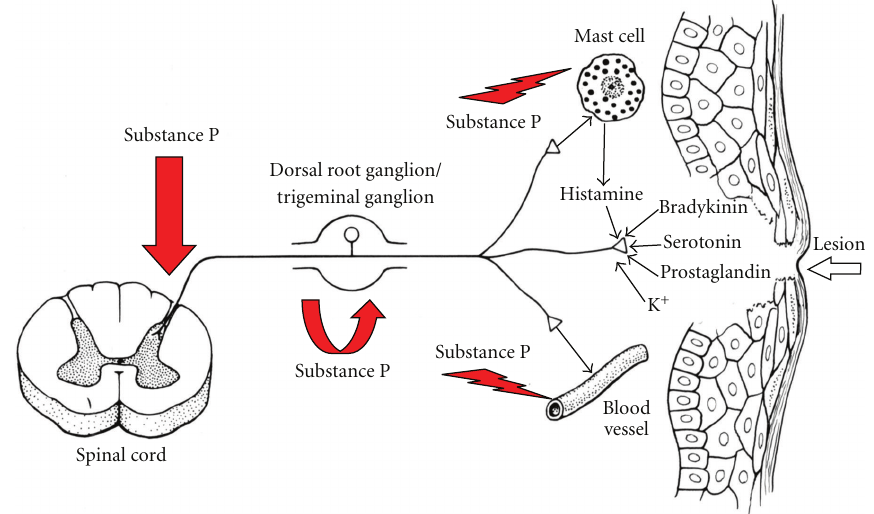
Figure 1: The role of substance P in neurogenic inflammation.